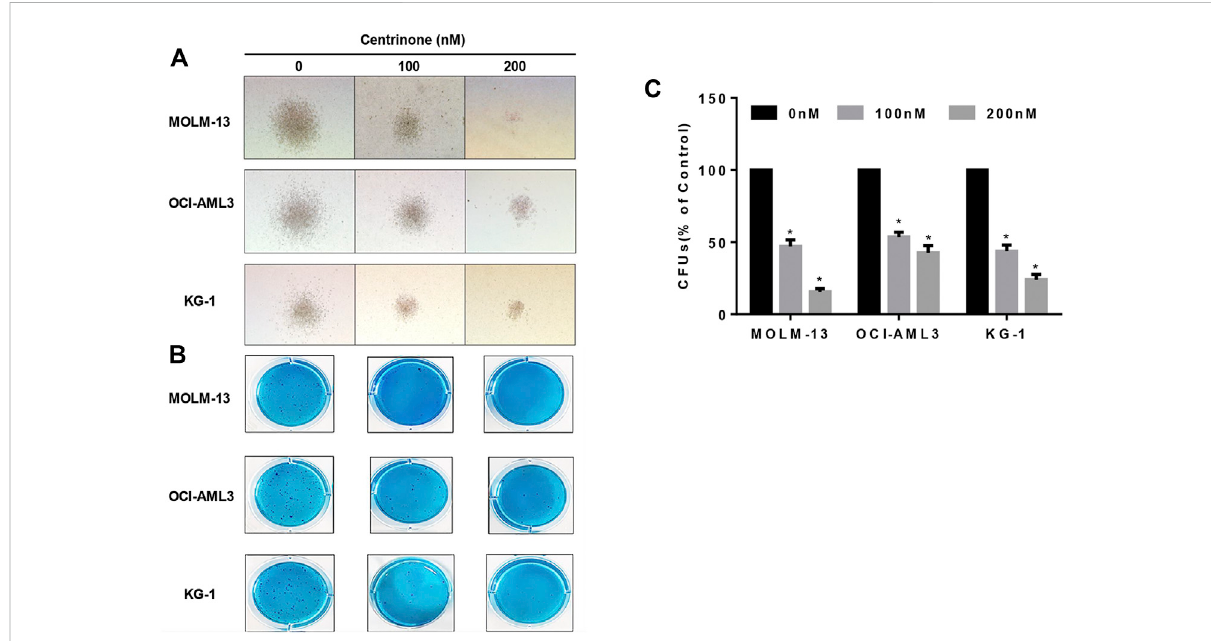
FIGURE 5 Centrinone reduced the clonogenic ability of AML cell lines. AML cells were co-incubated with Centrinone for 14 days. Single colonies were observed and counted under the microscope. (A) Microscopic observation of cell colony generation size (100×). (B) The number of colony generations was observed after Giemsa staining. (C) Statistical analysis of the number of colony formation of MOLM-13, OCI-AML3, and KG-1 AML cells (Compared with the control group, * p <